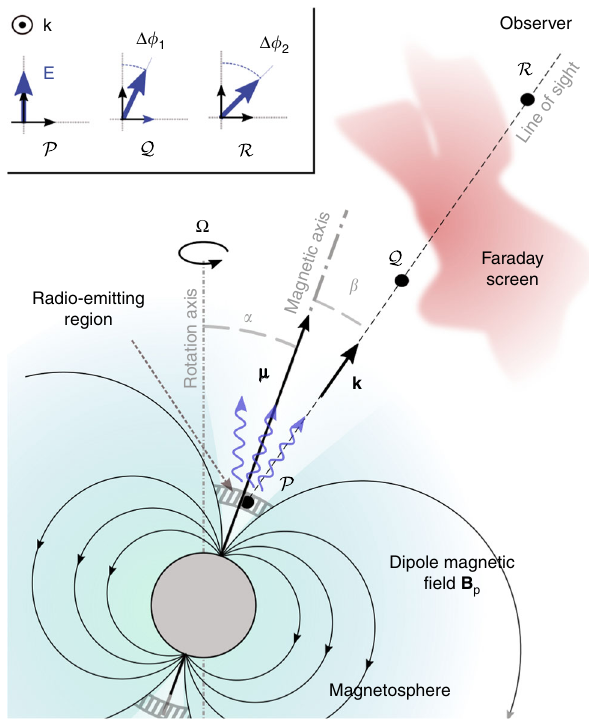
Fig. 1 Illustration of the different contributions to pulsars ’ emission polarisation rotation. Polarisation rotation is typically assumed to stem from Faraday rotation between Q and R . But wave polarisation also contains information on the magnetosphere properties between points P and Q , and in particular on the magnetosphere rotation